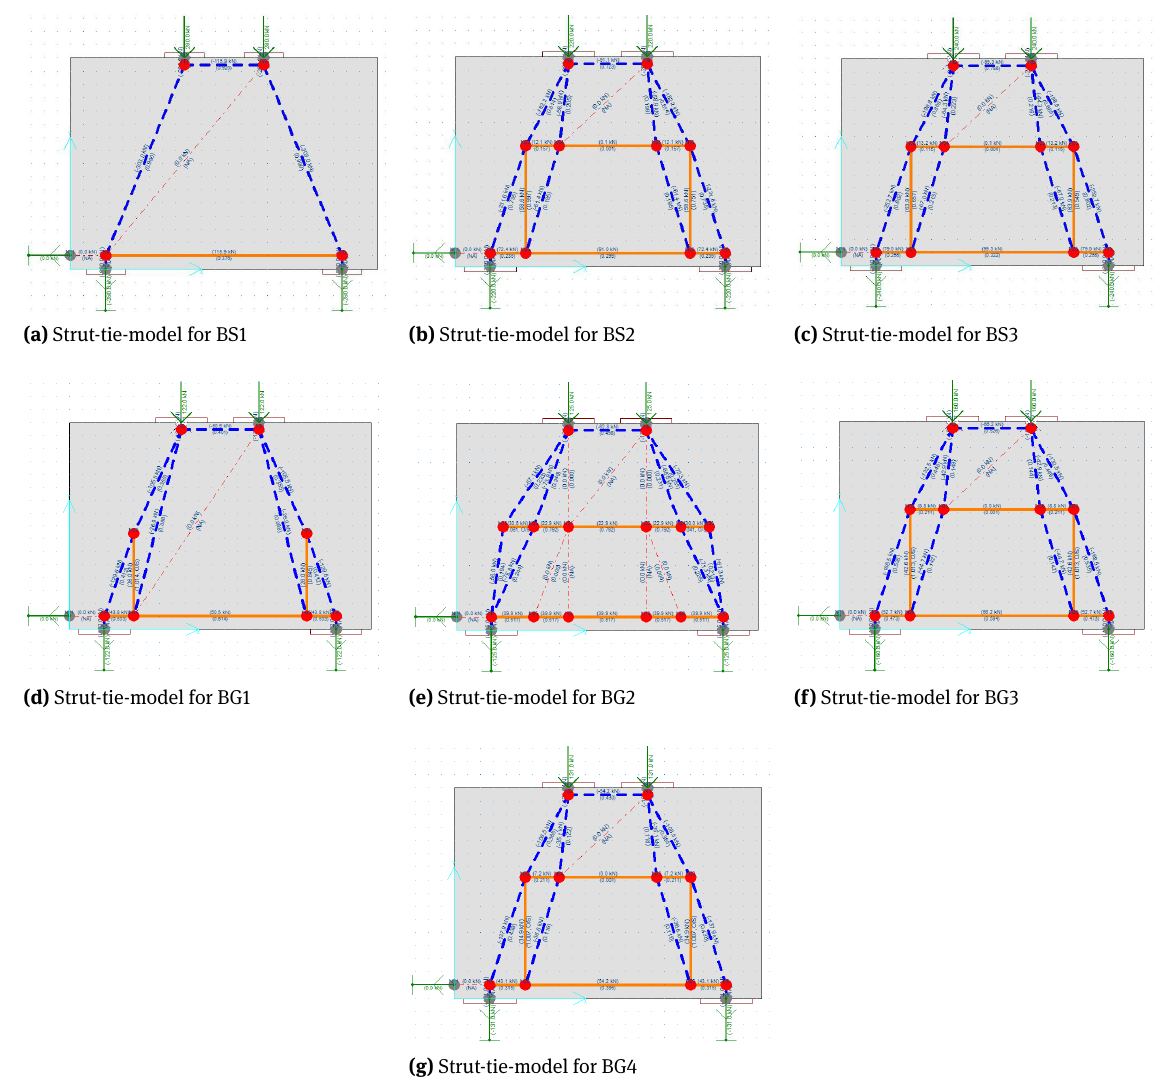
Figure 30: Stress ratios in strut-tie-model accordance to ACI